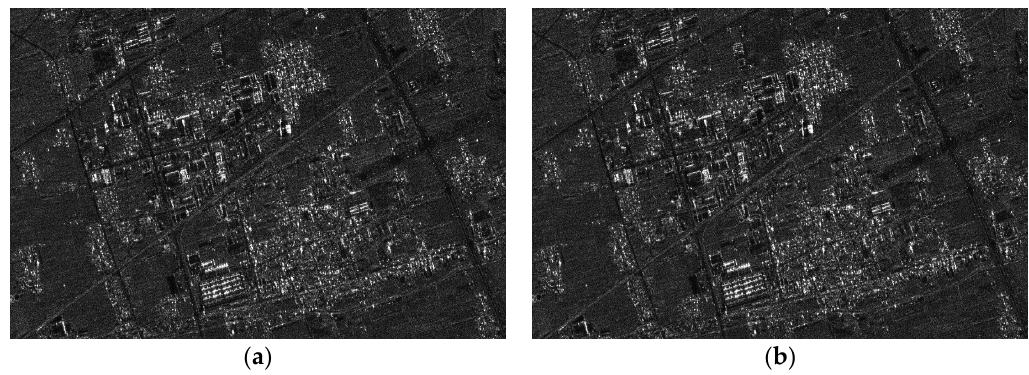
Figure 13. Results of area B (from top to bottom is range, and from left to right is azimuth): ( a ) standard full-aperture CSA; ( b ) proposed algorithm.